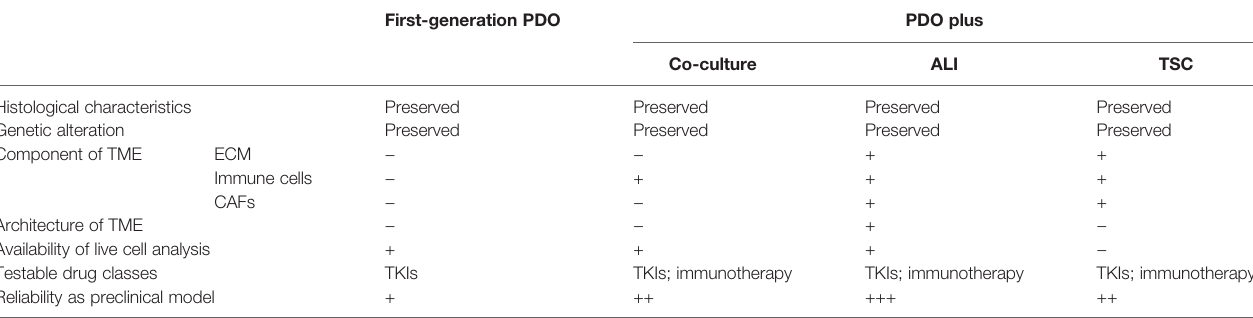
TABLE 2 | Comparisons between conventional and next-generation patient-derived models of renal cell